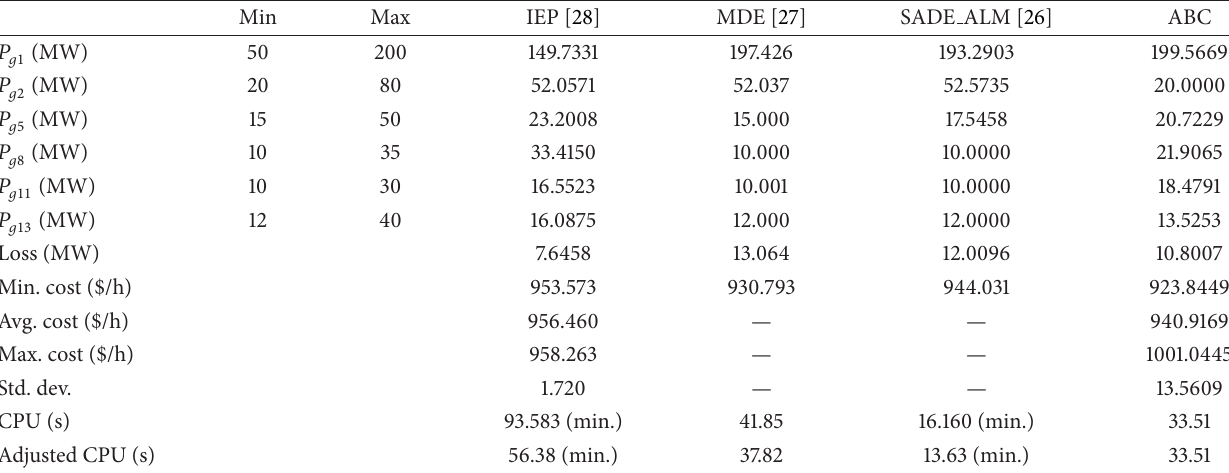
Table 2: Result comparison for the IEEE-30 bus system with valve point effects.